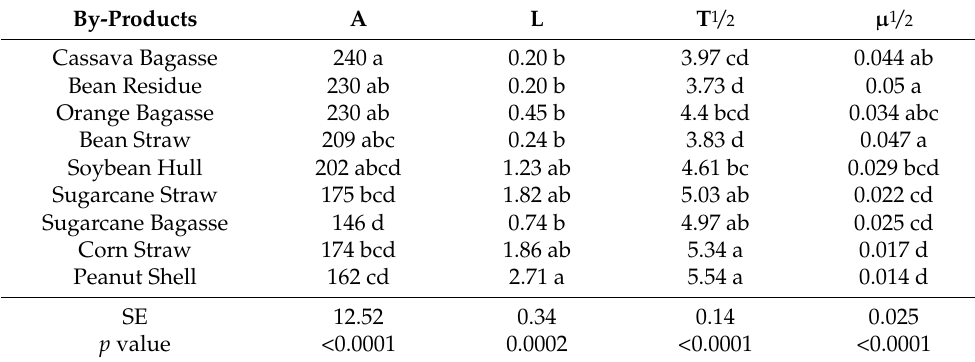
Table 4. Kinect parameters related to rumen